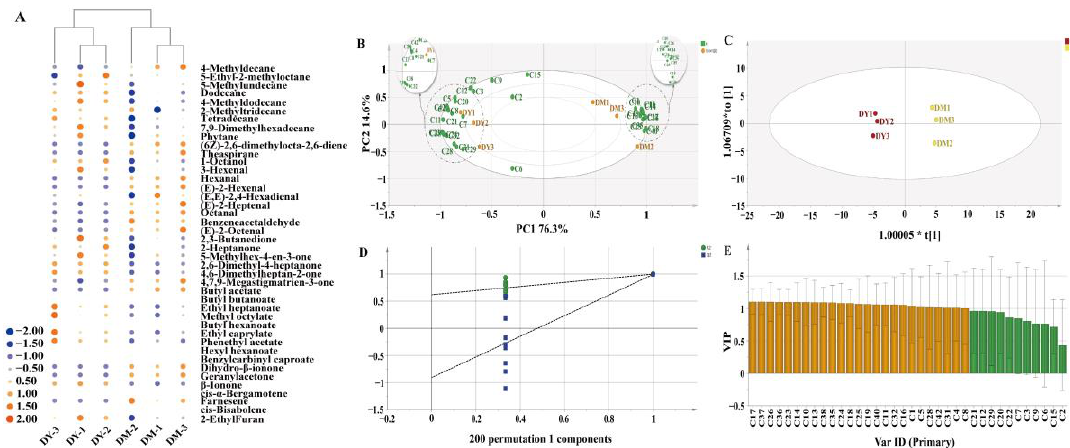
Figure 3. ( A ) Cluster heat map analysis. The size and color of each circle provide information on the corresponding volatile compounds in D. delavayi fruit samples. Blue corresponds to downregulation, orange corresponds to upregulation, and the circle size represents the degree. A blank means a lack of enrichment. ( B ) PCA biplot. ( C ) OPLS-DA score plot: R 2 X = 0.908, R 2 Y = 0.997, Q 2 = 0.99. ( D ) cross-validation plot for the OPLS-DA model with 200 calculations in a permutation test: R 2 = (0.0, 0.636), Q 2 = (0.0, − 0.878). ( E ) VIP scores. Orange corresponds to compounds with VIP > 1 and green represents compounds with VIP < 1.